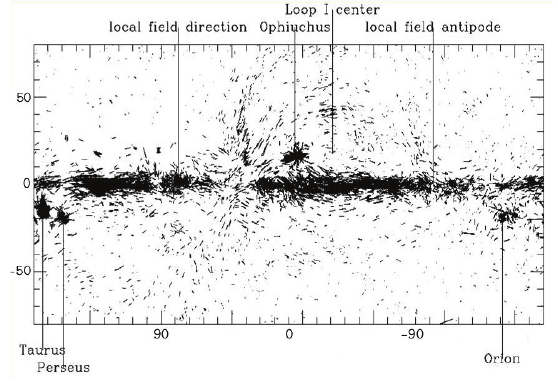
Figure 1. All-sky map in Galactic coordinates (with the Galac- tic center in the middle, longitude l increasing to the left, and latitude b increasing upward) of the polarization half-vectors of 8662 stars from the compilation by [12]. The polarization half- (cid:3) B vectors directly trace the orientation of ⊥